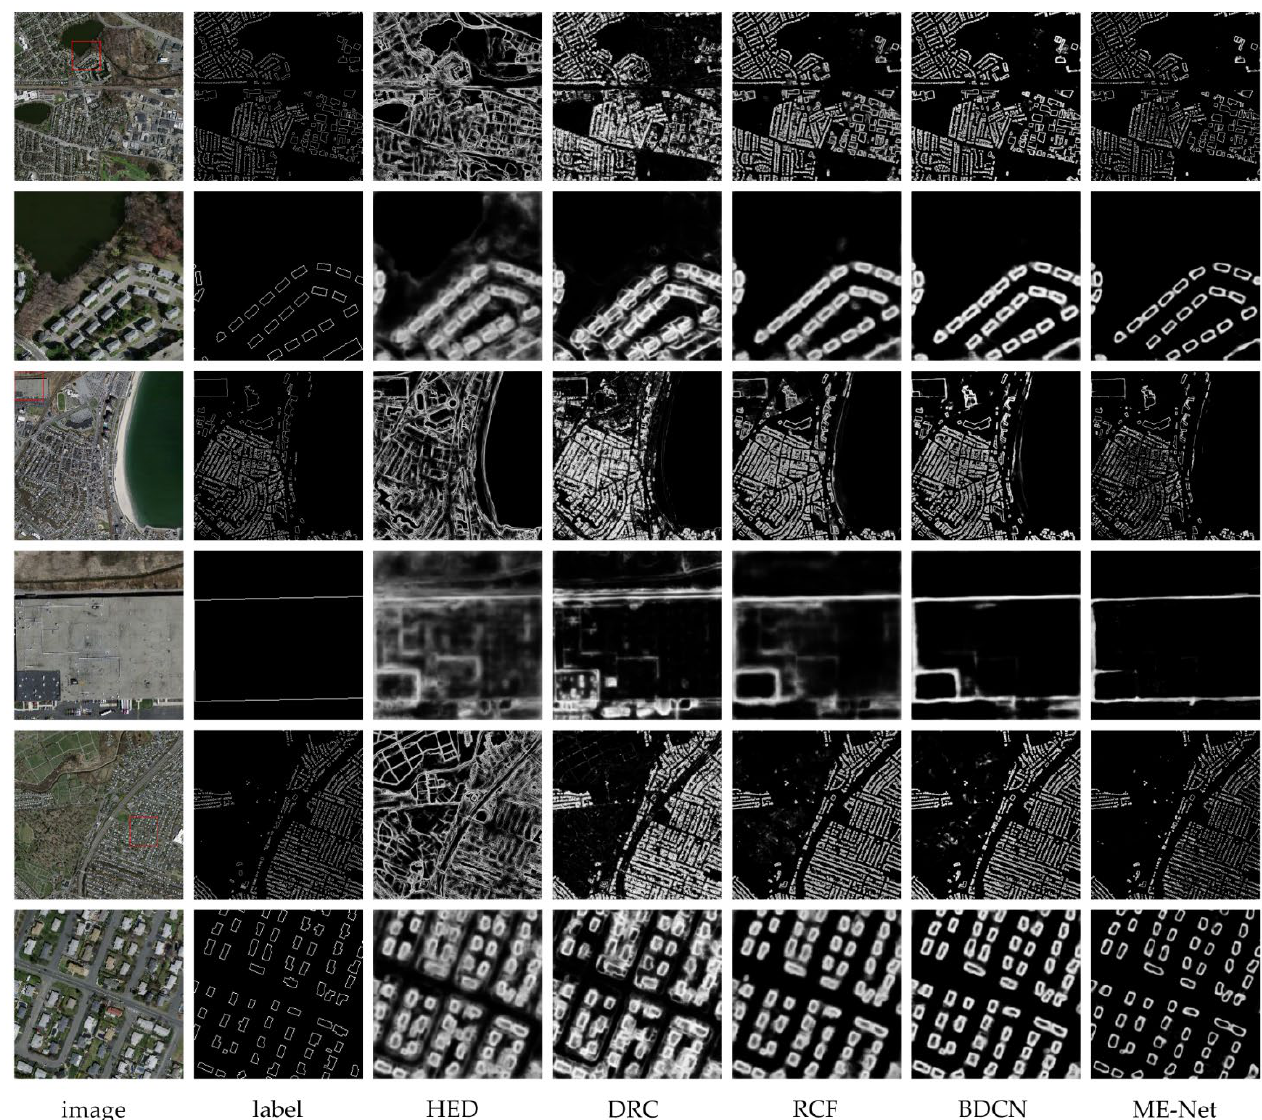
Figure 9. Examples of building edge probability maps produced by five models on the Massachusetts dataset. Columns 1–7 are the images, ground truth labels and prediction results from HED, DRC, RCF, BDCN, and ME-Net, respectively. The even rows are the selected patches of red boxed areas in the odd rows.